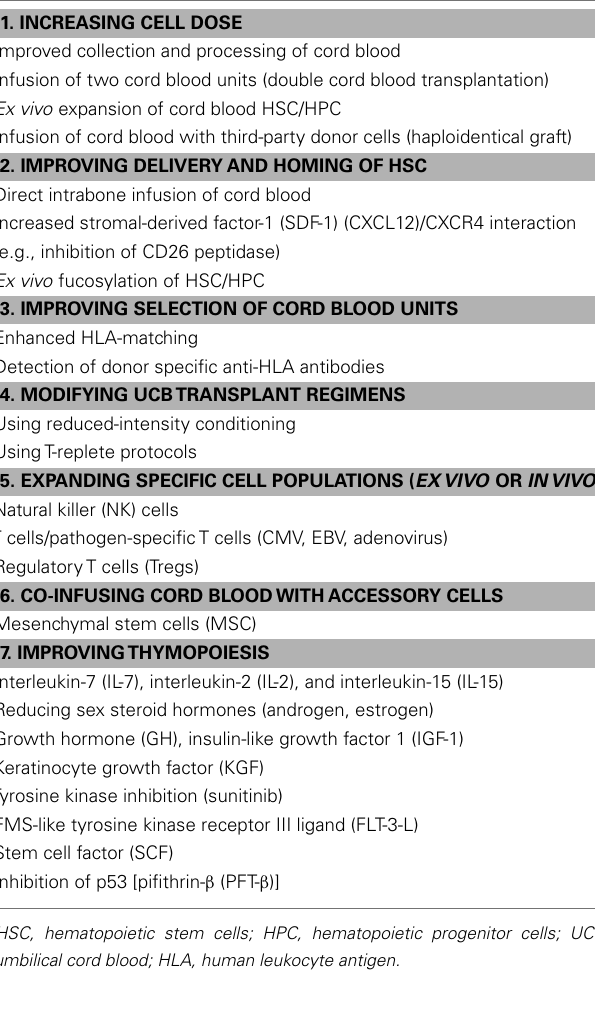
Table 1 | Methods to improve engraftment and immune reconstitution in UCB transplantation